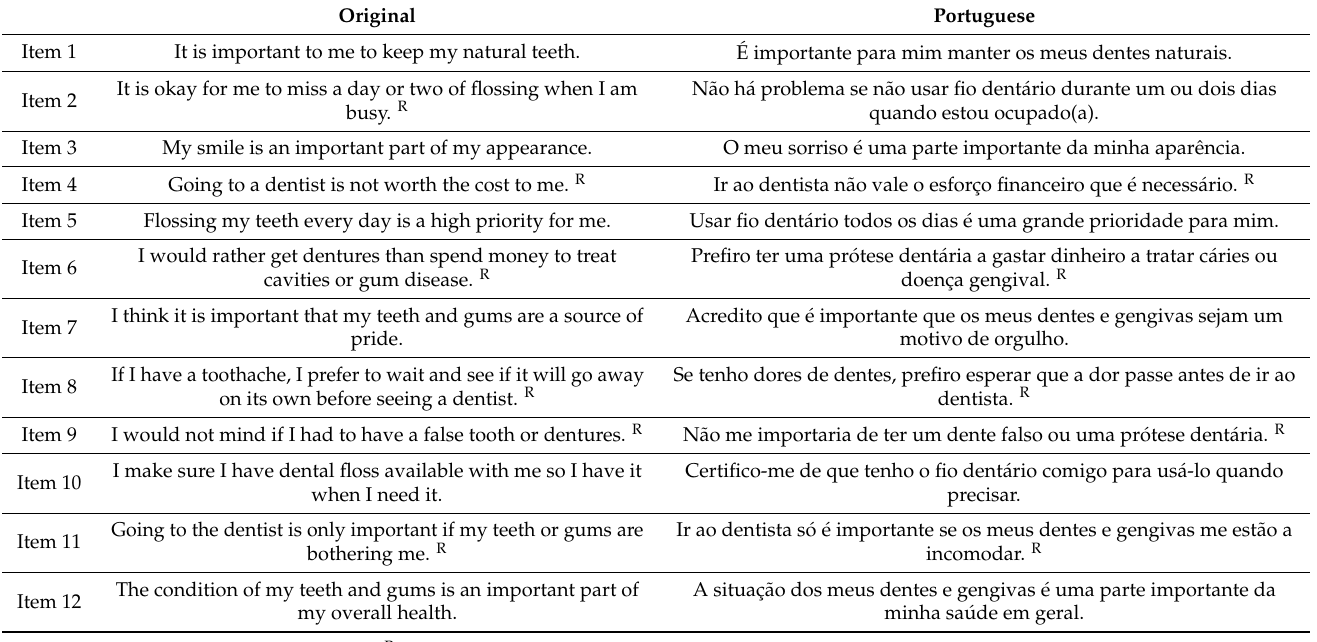
Table 1. Original and Portuguese versions of the OHVS